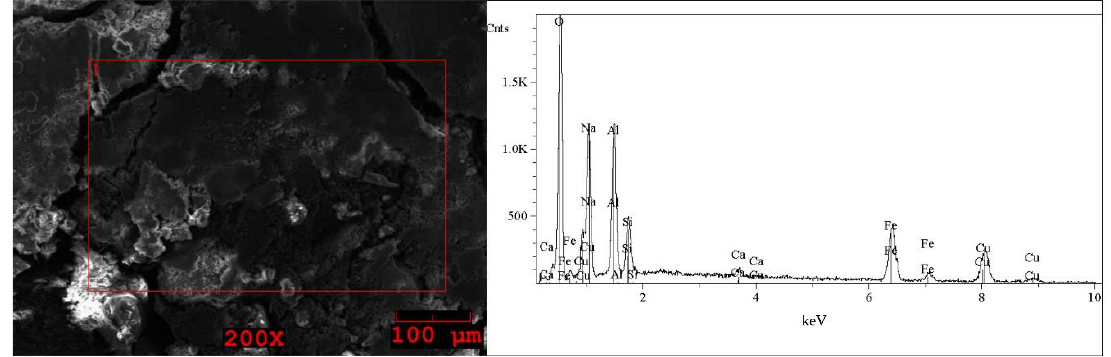
tion I and EDS spectrum taken from the area marked in the image.